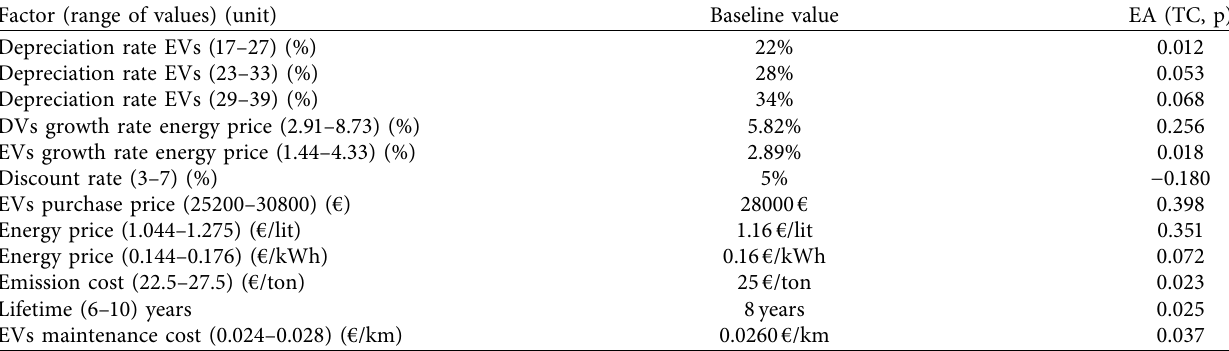
Table 4: Per-km discounted elasticity analysis of total cost for diferent